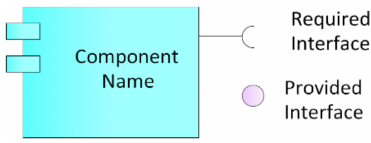
Figure 1. Representation of a